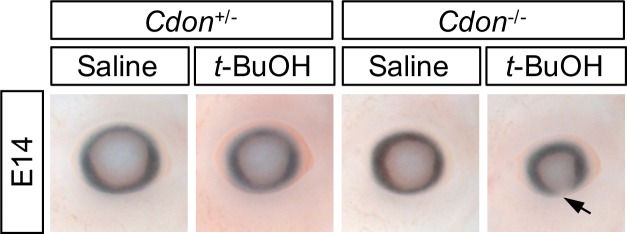
t-BuOH induces eye defects in Cdon mutant mice.t-BuOH-treated Cdon-/- mice displayed micropthalamia and/or ventral coloboma (arrow), whereas t-BuOH-treated Cdon+/- mice and saline-treated mice of either genotype did not.